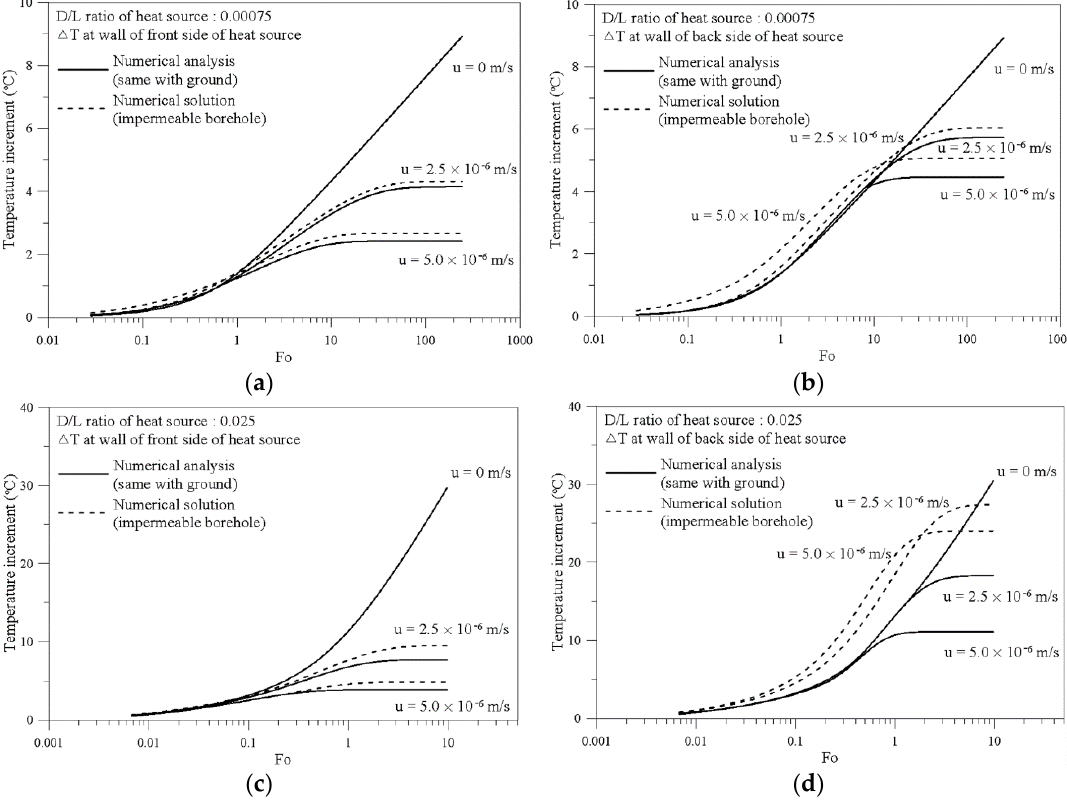
Figure 14. Temperature responses at heat source wall with different groundwater velocity and different permeability of borehole. Temperature increment at ( a ) front side of heat source (D/L ratio = 0.00075); ( b ) back side of heat source (D/L ratio = 0.00075); ( c ) front side of heat source (D/L ratio = 0.025); ( d ) back side of heat source (D/L ratio = 0.025).